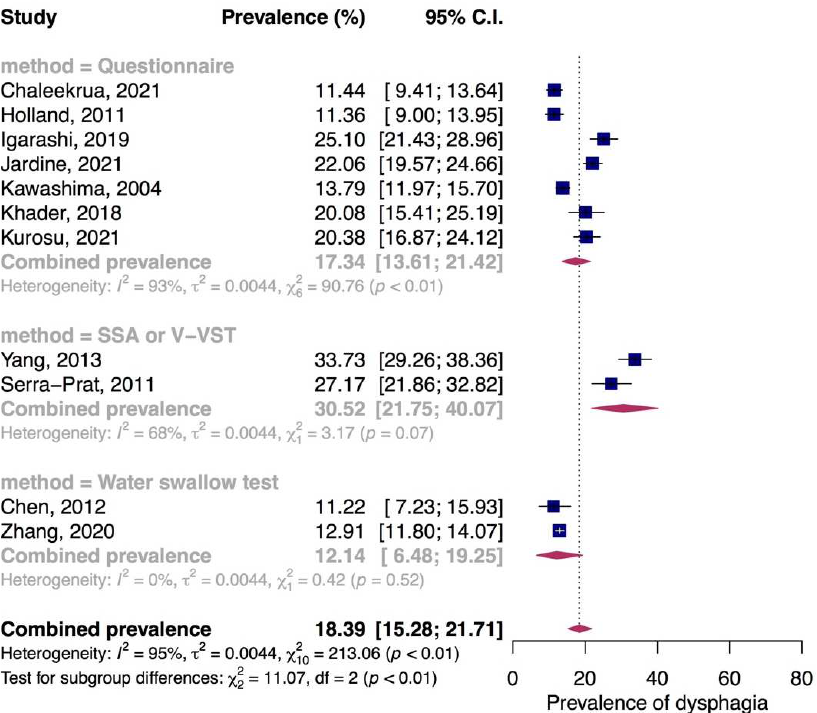
Figure 2. Prevalence of dysphagia in community-dwelling elderly. SSA, Standardized Swallowing Assessment; V-VST, volume-viscosity swallow test.